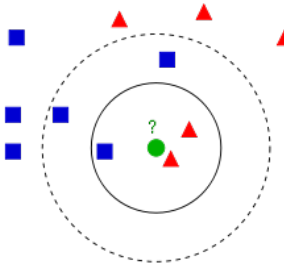
Figure 1. Fig. 1. KNN classification. The new sample(green circle) might be classified either into the first class,(blue squares) or to the second class(red